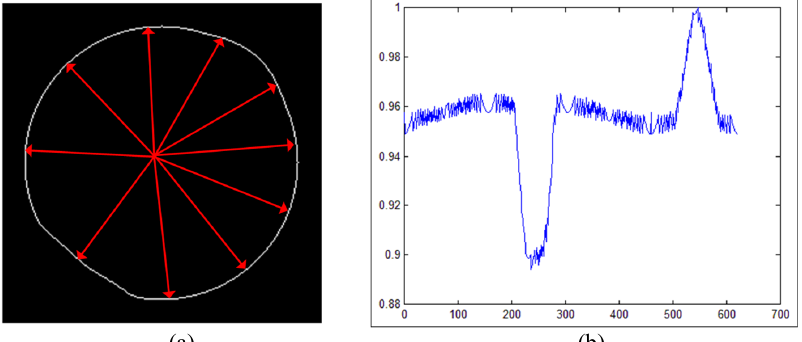
Fig. 4. The corresponding distance values from the mass center to the boundary points of a concentric circle: (a)